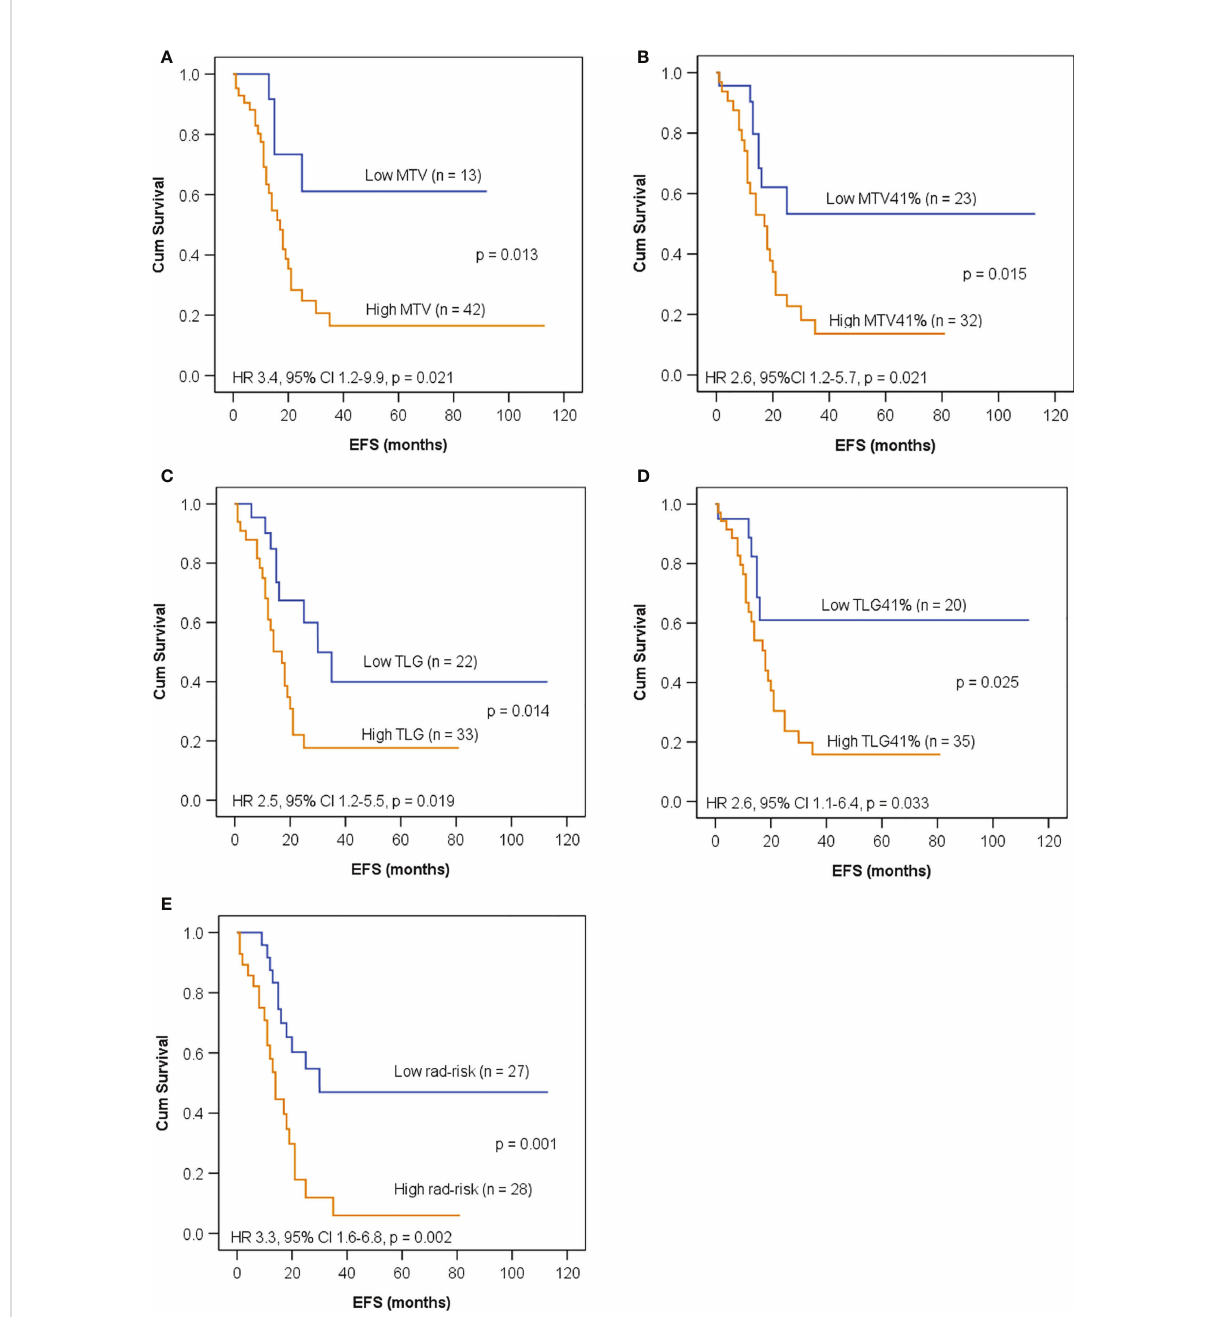
FIGURE 4 Kaplan – Meier curves for EFS in children with high-risk neuroblastoma in the training set according to (A) metabolic tumor volume (MTV) with a cutoff value of 120 ml; (B) MTV41% with a cutoff value of 65 ml; (C) total lesion glycolysis (TLG) with a cutoff value of 426 g; (D) TLG41% with a cutoff value of 141 g; (E)